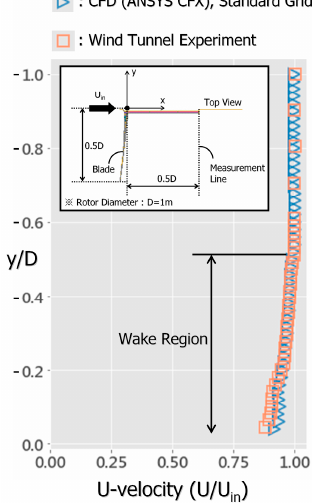
Figure 10. Comparison of time-averaged U-velocities in the measurement line (x = 0.5D). indicated by the dotted line in Figure 9a.